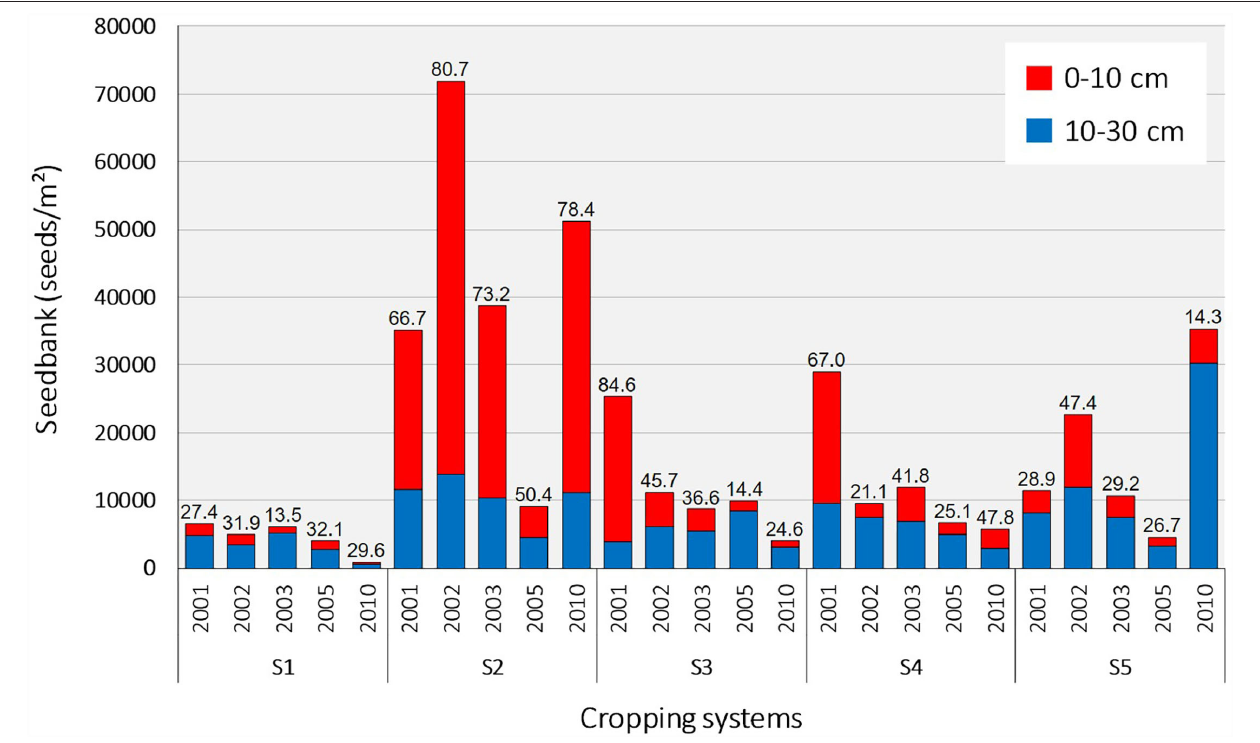
FIGURE 1 | Superficial (red) and deep (blue) weed seedbank (total number of seeds.m − ² ) assessed during the cropping system experiment (2001–2017) testing four integrated weed management systems (S2–S5) compared a reference system (S1). Figures on top of the bars represent the percentage of seeds located in the top horizon (red bar, 0–10cm). Only the data collected from 2001 to 2010 were presented because no investigation of the seedbank was done afterwards.